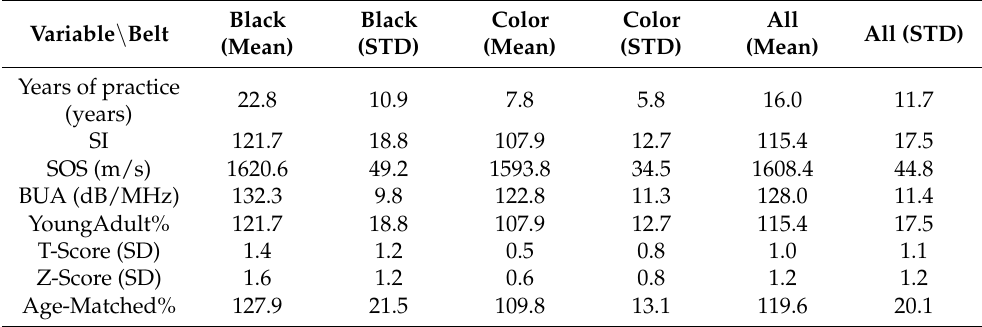
Table 2. The breakdown table of descriptive statistics of mean values and standard deviations of variables characterizing the black and color belts in the study group.